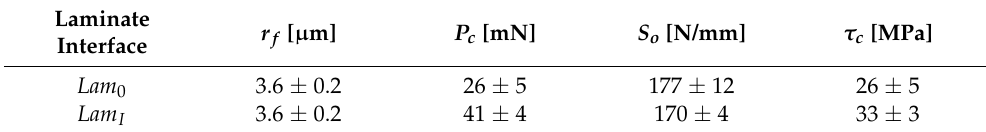
Figure 11. Push-in test: representative P − h curves for untreated ( Lam 0 ) and treated laminates ( Lam I ). Critical load, P c , is indicated for each case. Table 4. Fiber-matrix interface parameters extracted from the push-in